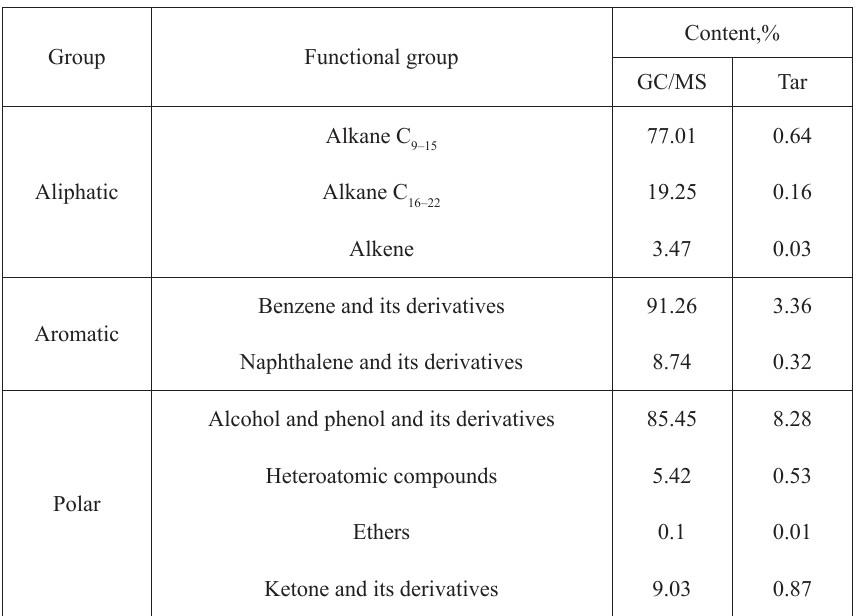
Table 7. The results of GC/MS analysis of the middle distillation fraction (180–250 °C) of pyrolysis